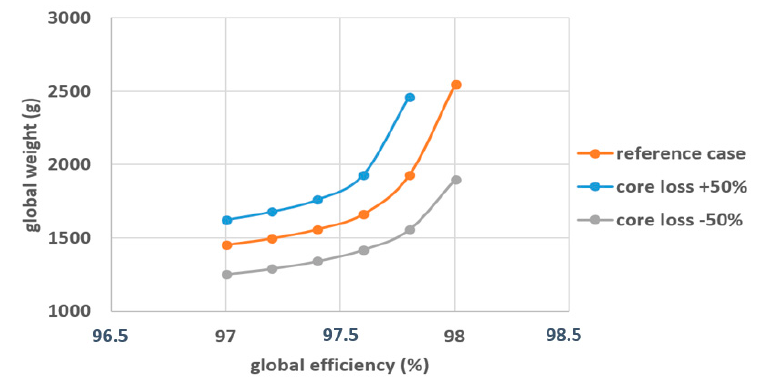
Figure 16. Impact of core loss model accuracy on the result.